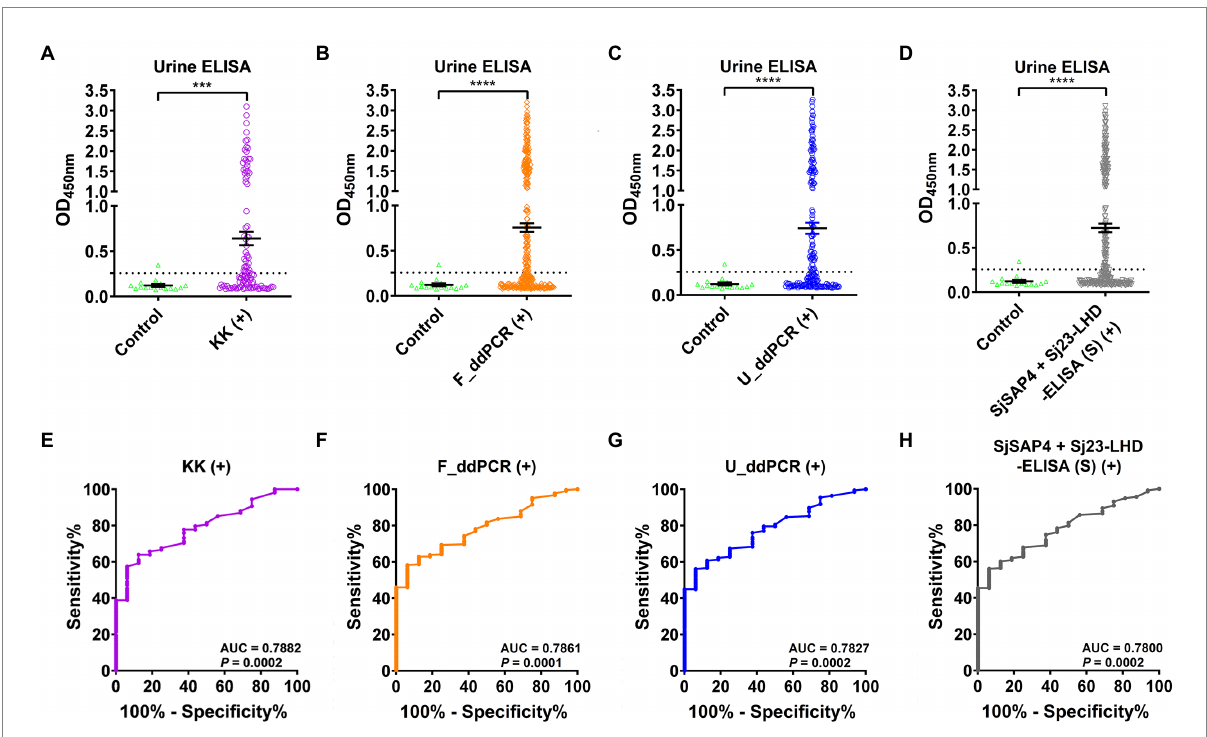
FIGURE 2 Urinary IgG levels against the antigen combination SjSAP4 + Sj23-LHD in different subgroups. (A–D) Scatter plots showing the urine IgG responses to SjSAP4 + Sj23-LHD in the KK-positives ( n = 108; A ), F_ddPCR-positives ( n = 307; B ), U_ddPCR-positives ( n = 196; C ) and serum SjSAP4 + Sj23-LHD- ELISA-positives ( n = 272; D ), respectively, for the diagnosis of schistosomiasis japonica. Urine samples from 16 healthy individuals were used as controls. p values were determined using the Mann–Whitney U -test. *** p < 0.001; **** p < 0.0001. (E–H) ROC analysis was performed to evaluate the capability of the urine ELISA in discriminating the healthy control group and different subsets of the cohorts [KK-positives (E) , F_ddPCR- positives (F) , U_ddPCR-positives (G) and serum SjSAP4 + Sj23-LHD-ELISA (S)-positives (H) ,